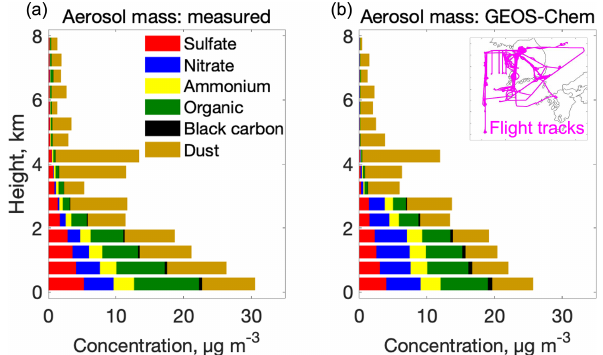
Figure 1. Vertical profiles of aerosol mass during KORUS-AQ. Panel (a) shows the mean vertical distributions of observed mass concentrations of major aerosol components at ambient tempera- ture and pressure. Panel (b) is the same as (a) but from the GEOS- Chem model sampled along the flight tracks (inset). We derive dust concentration from SAGA Ca 2 + and Na + following Shah et al. (2020) by assuming that non-sea-salt Ca 2 + accounts for 7.1% of dust mass: [dust] = ([Ca 2 + ] − 0.0439 [Na + ] / 2) / 0.071, where the brackets denote mass concentration. Modeled dust is shown for particles with geometric diameter < 2.5µm, to be consistent with SAGA measurements (Table 2, footnote e). Measured sulfate, ni- trate, ammonium, and organic aerosol concentrations are from the AMS instrument (values from the SAGA instrument are shown in Fig. S4). All data are averaged over 500m vertical bins. Here and elsewhere, we excluded pollution plumes diagnosed by either NO 2 or SO 2 > 10ppbv (3.4% of all the